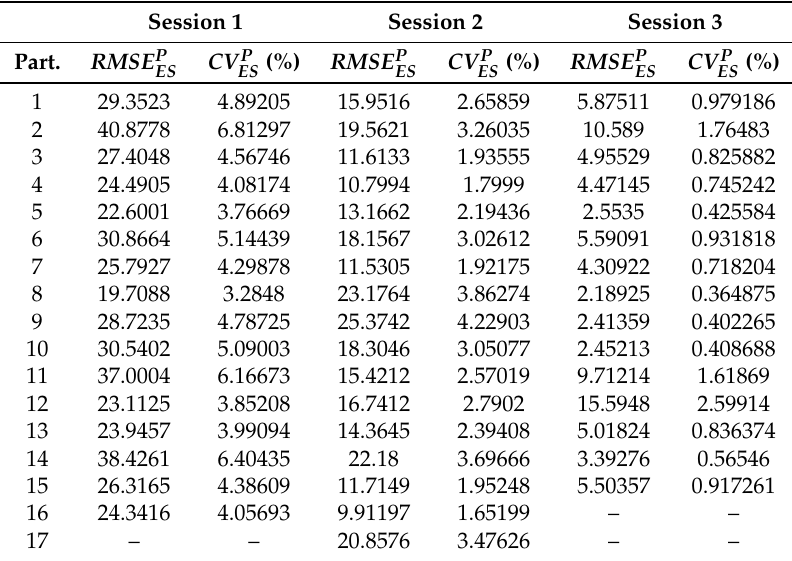
Table 7. Forecast errors of the simple exponential smoothing model ( ES ) for the three